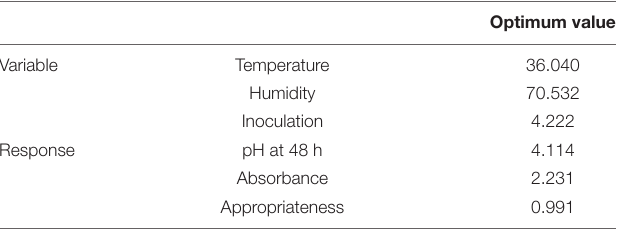
TABLE 3 | The optimal value of different independent variables (temperature, humidity, and inoculation) and responses based on the highest absorption rate at the lowest pH.